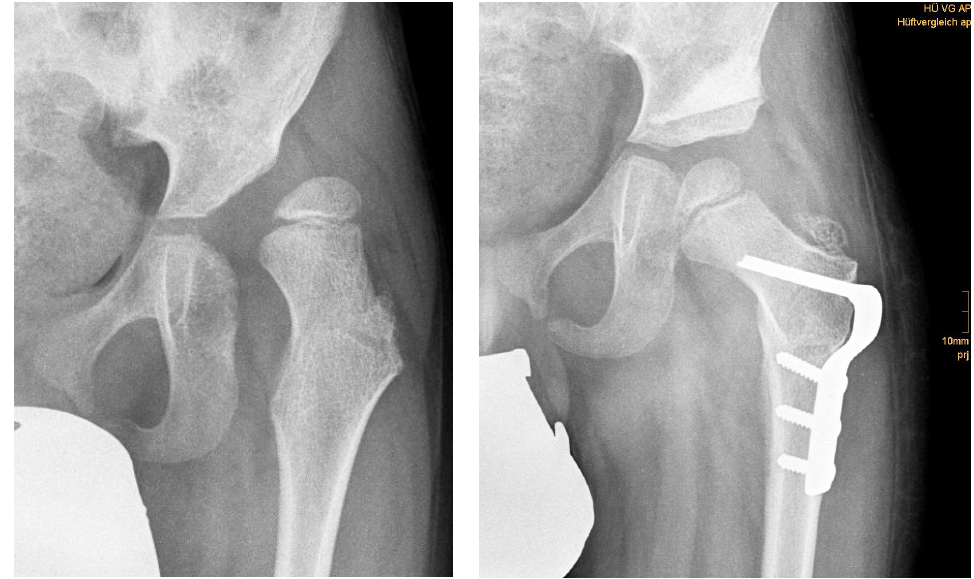
Figure 1. ( left ) Anteroposterior radiograph of a six-year-old male with NDH; ( right ) result 3 months postoperatively.